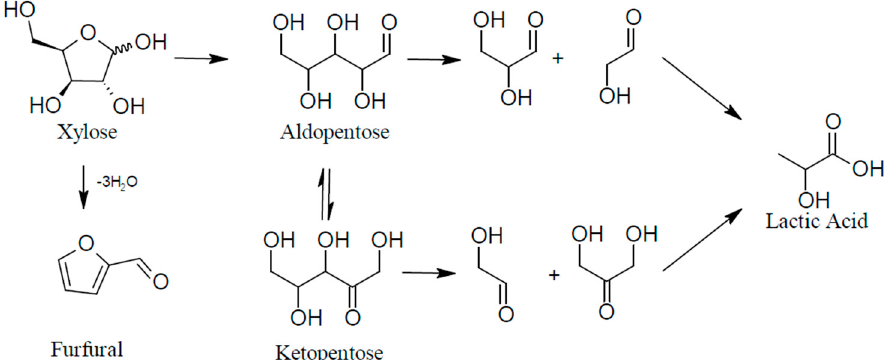
Figure 2. Reaction pathway for pentoses using Sn-Beta.